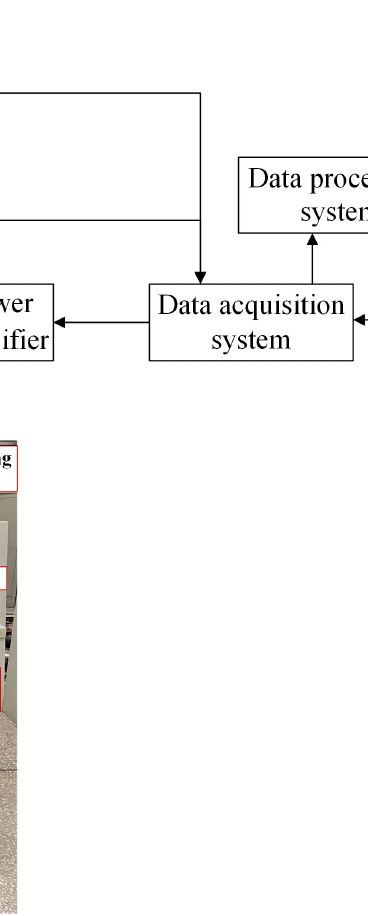
Figure 8. Exciter experiment bench installation diagram.